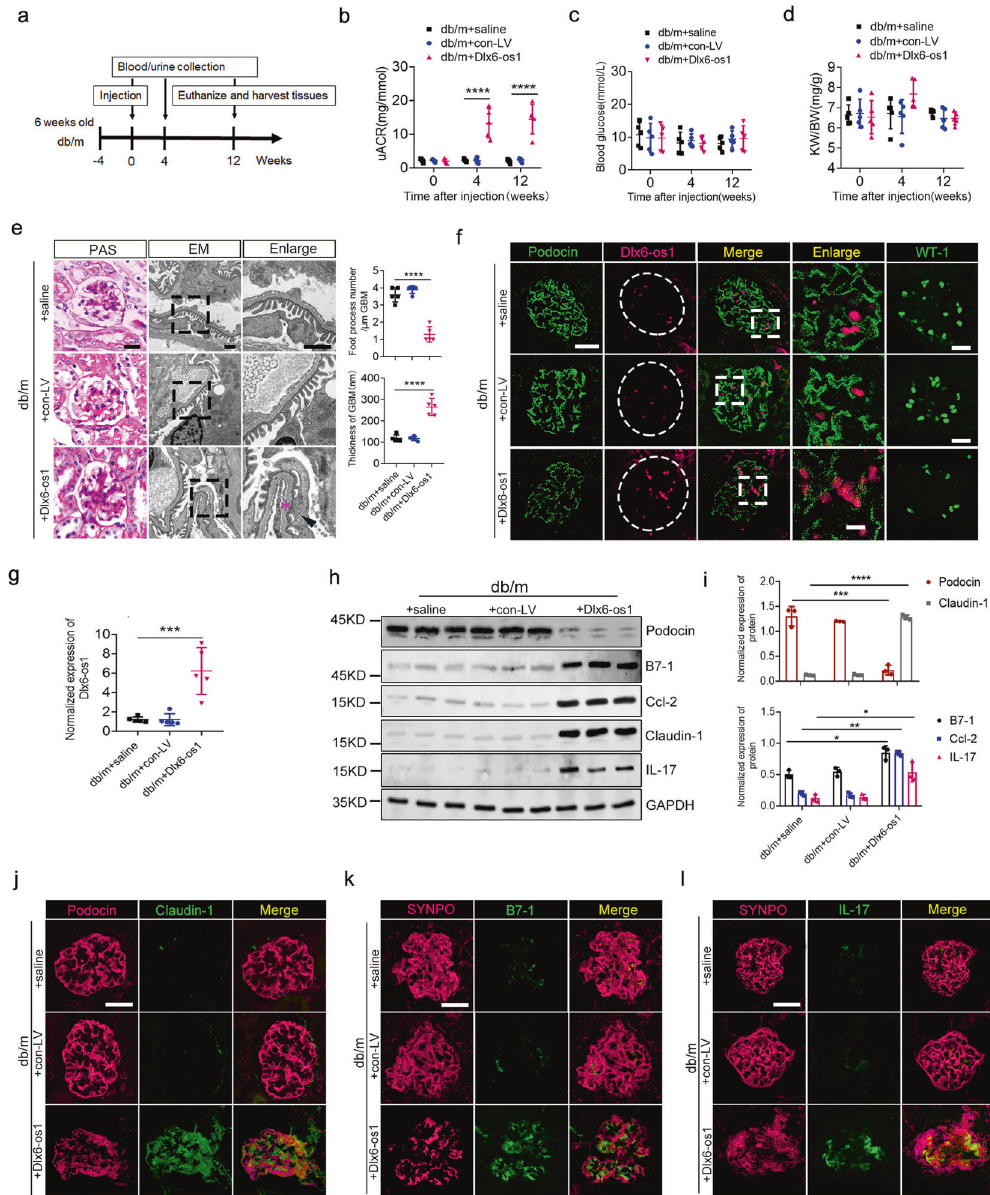
Fig. 3 Glomerular podocyte injury induced by lncRNA Dlx6-os1 overexpression in phenotypically normal db/m mice. a Treatment fl ow chart. Mice were on an adaptive feeding for 4 weeks before the experiment ( − 4 to 0 weeks). The db/m mice were randomly allocated to three groups: saline control (db/m + saline), blank virus control (db/m + con-LV), and lncRNA Dlx6-os1-overexpressing lentivirus (db/m + Dlx6-os1) groups. b – d The uACR of the (db/m + Dlx6-os1) mice is signi fi cantly higher than that of the (db/m + saline) mice ( b ), but there are no signi fi cant differences in the random blood glucose level ( c ) or kidney weight/ body weight (KW/BW) ratio ( d ). **** P < 0.0001. n = 5 mice/ group (one-way ANOVA plus Dunnett ’ s multiple comparisons test). e Periodic acid-Schiff (PAS) staining and electron microscopy (EM) analysis of kidney tissues and podocytes from db/m mice 12 weeks after lentivirus injection. The statistical charts show the number of foot processes per micrometer and the thickness of the basement membrane. Five visual fi elds were analyzed per sample, PAS bar = 20 µm; EM bar = 1 µm). **** P < 0.0001 ( unpaired t -test). n = 5 mice/group. f FISH-based detection of the location and level of the lncRNA Dlx6-os1 expression in paraf fi n-embedded mouse kidney tissues. LncRNA Dlx6-os1 is upregulated (magenta dots). Podocin (green) and WT-1 expressions are reduced. Images are representatives of three separate experiments. Scale bar = 20 µm. g The expression of lncRNA Dlx6-os1 in the primarily isolated podocyte as determined by qRT-PCR. *** P < 0.001 (unpaired t -test). n = 5 mice/group. h Western blots of isolated glomeruli from mouse kidneys to determine the levels of podocin, B7-1, ccl-2, IL-17, and claudin-1 protein. GAPDH was used as the loading control. n = 3 mice/group. i Quanti fi cation from the western blot data shown in h . The intensity of the bands was analyzed in ImageJ and normalized to that of GAPDH ( n = 3). * P < 0.05, ** P < 0.01, *** P < 0.001, **** P < 0.0001 (one-way ANOVA, plus Tukey ’ s multiple comparisons test). j – l Comparison of podocin ( j , magenta), SYNPO (synaptopodin, k and l , magenta), claudin-1 ( j , green), B7-1 ( k , green), and IL-17 ( l , green) expression levels and localization sites in OCT-embedded frozen kidney tissues. Images are representative of three separate experiments. Scale bar = 20 µm.